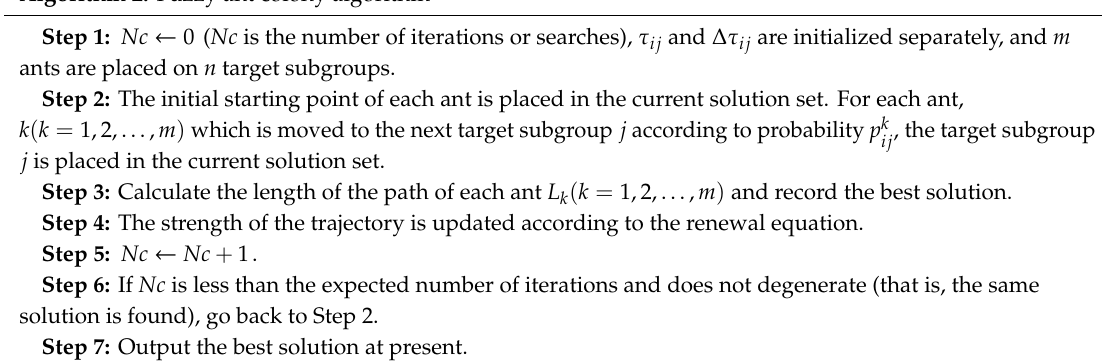
Algorithm 2: Fuzzy ant colony